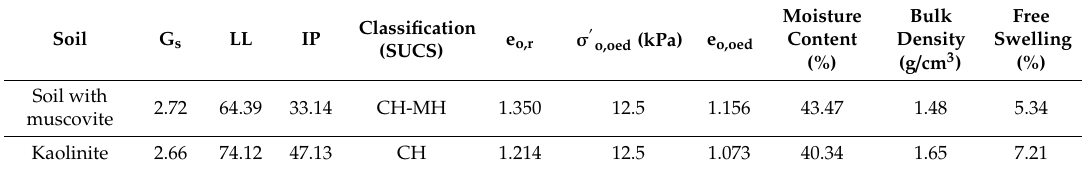
Table 2. Geotechnical properties of the two soils tested.